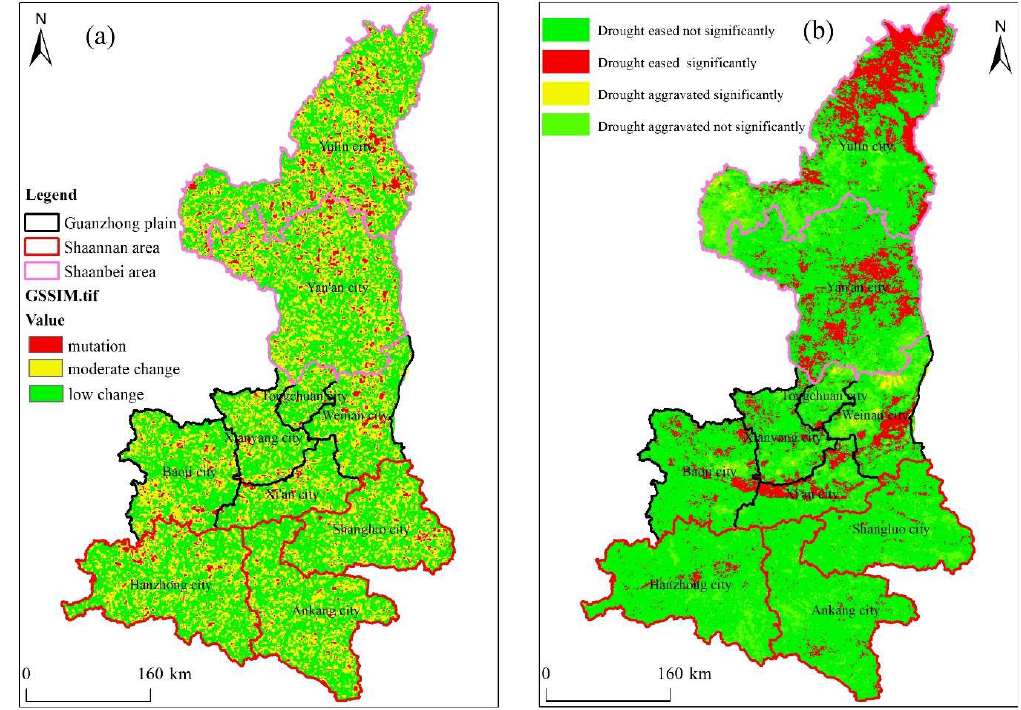
Figure 12. Comparison of GSSIM and linear regression analysis. ( a ) GSSIM between 2000 and 2016. ( b ) Significant linear regression slope values for trends derived from TVDI observations during 2000–2016 (reliable at 5% significance